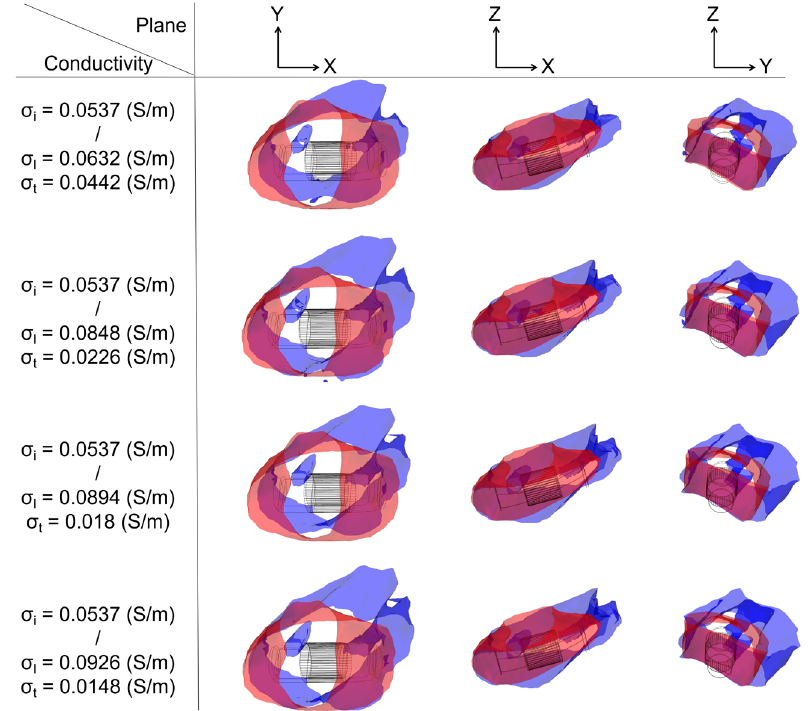
Figure 11. Under the condition of the PFA, the amplitude is 1000 V; at ablation target 2, the ablation isosurface distribution is generated by different ACs and ICs.